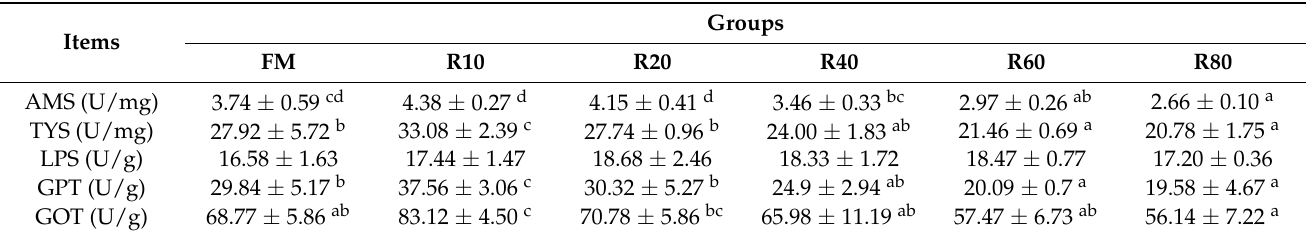
Table 8. Effects of RPP replacing fishmeal on hepatopancreas digestive and metabolic enzyme activities for L. vannamei .